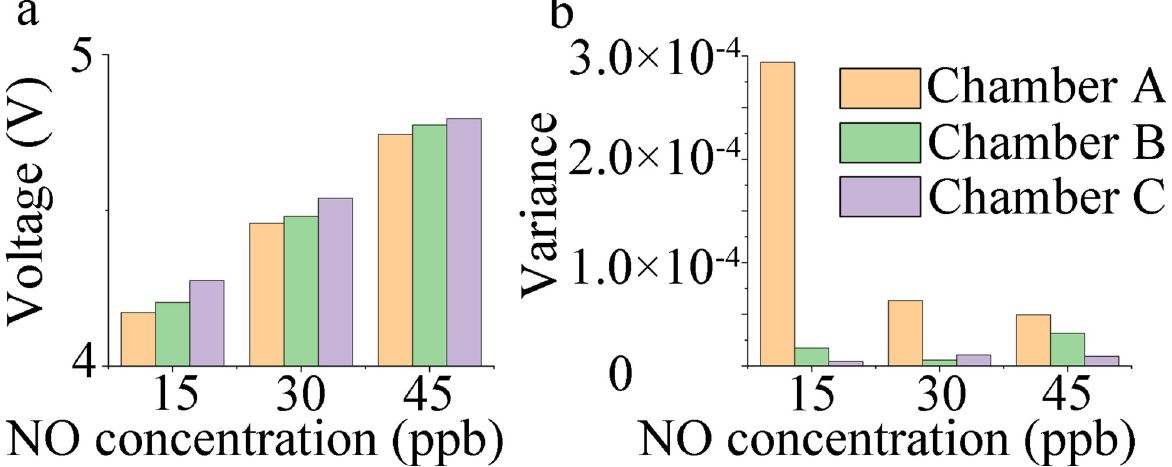
Fig 8. Histograms of mean and variance of sensor response voltage. (a) Voltage response mean of the sensor under the three NO gas concentrations. (b) Variance of sensor response voltage at the three NO gas concentrations.